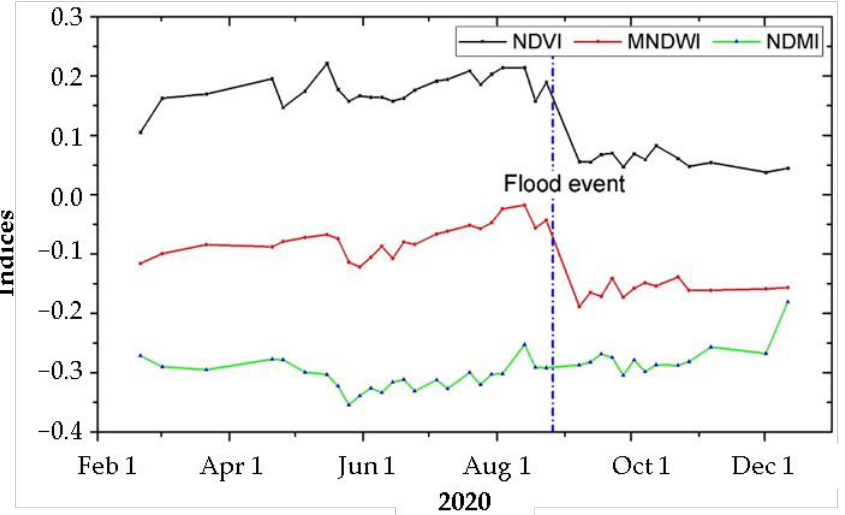
Figure 9. Time series of the NDVI, MNDWI, and NDMI over the course of one year in affected area. The blue dotted line indicates the date of the flash flood in Charikar.